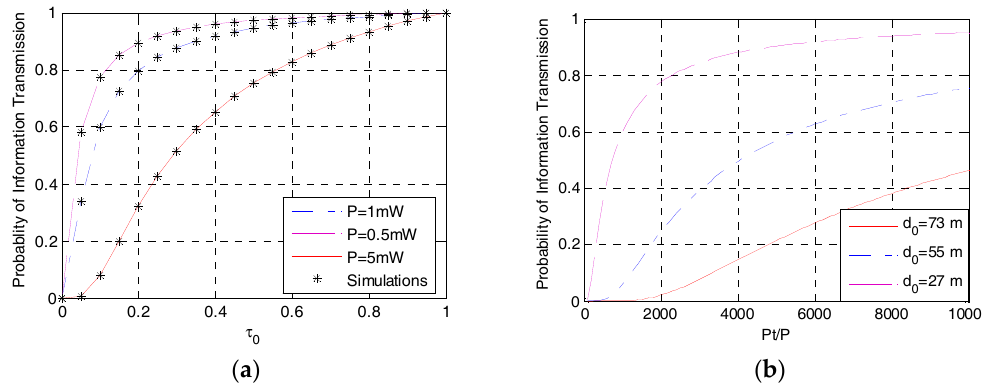
P P ( N = 15). Figure 3. Information transmission probability versus ( a ) EH time fraction and ( b ) P t / P ( N = 15). t